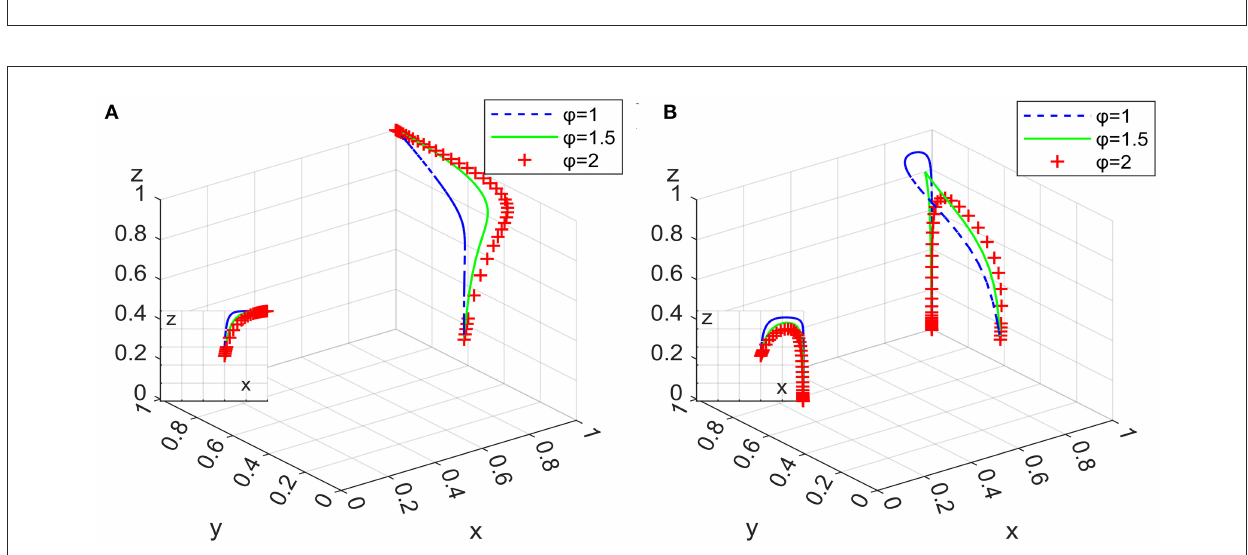
FIGURE10 Impact on subsidy intensity for clients in system L (A) and system P (B)